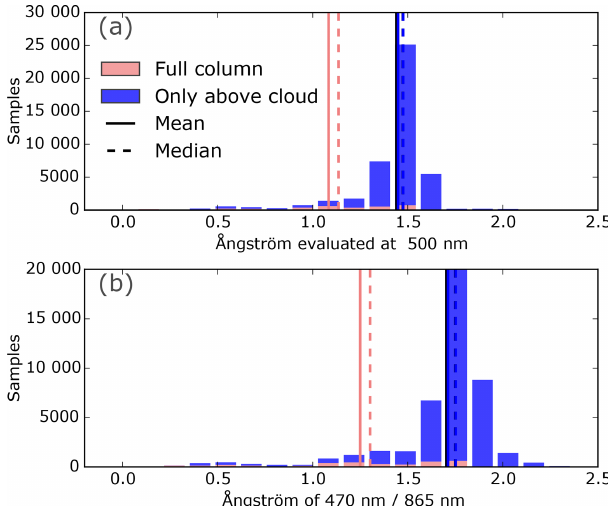
Figure 6. ACAOD spectra representing the mean, median, and standard deviation of measurements by 4STAR for selected wave- lengths, which have minimal influence of gas absorption and high signal to noise ratio. The mean measured ACAOD at each wave- length is shown in black, along with its mean uncertainty (as er- ror bars in black), median in blue circles, and the range of 1 stan- dard deviation surrounding the mean for all the measured ACAOD (dashed grey lines). The magnitude of the standard deviation is also included, denoted by a thin pink line with triangles.